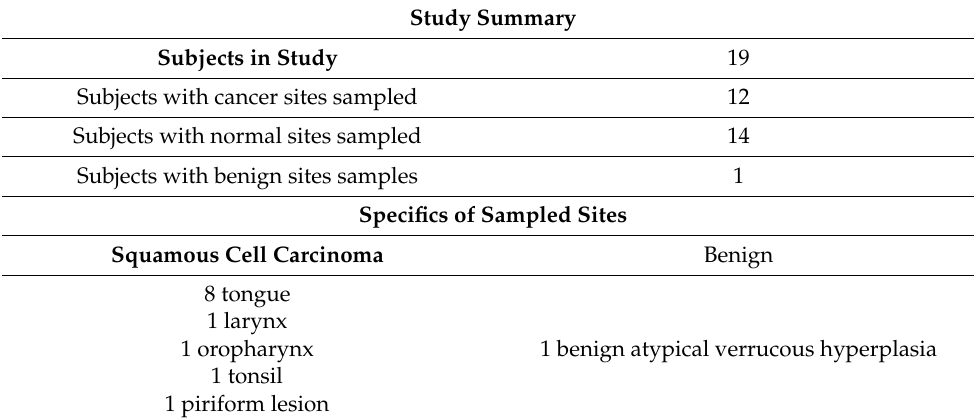
Table 1. Summary of the histopathologic diagnosis of the tissue samples used for spectroscopic